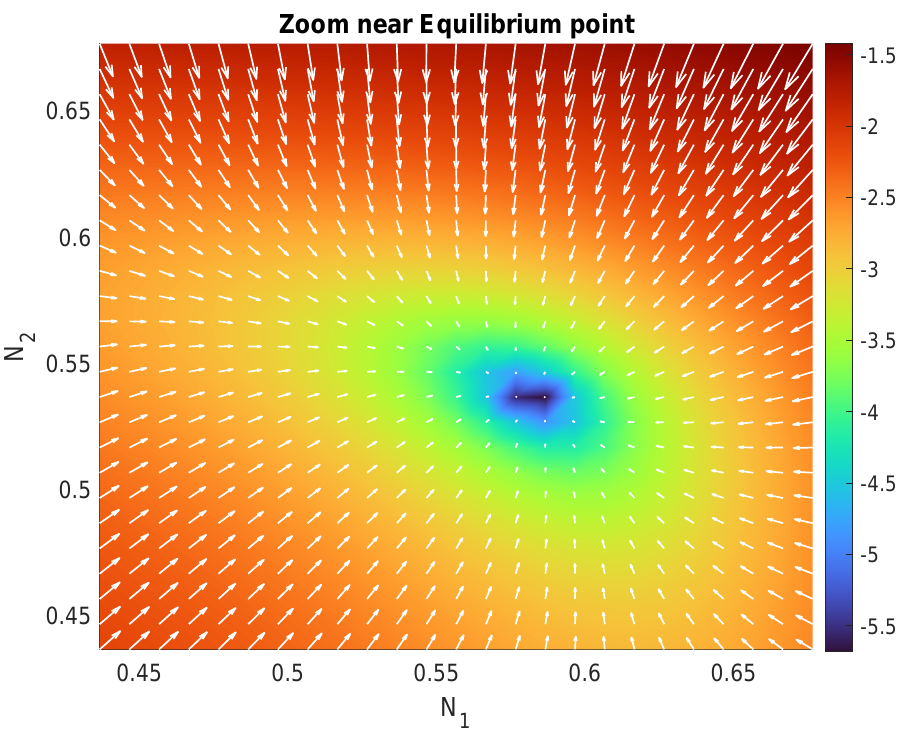
Figure 5. Zoomed-up view of Figure 4 in a neighborhood of the interior equilibrium point x ∞ = ( 0.5820,0.5366 ) . We can see how it clearly attracts all of the points surrounding the equi- librium point.